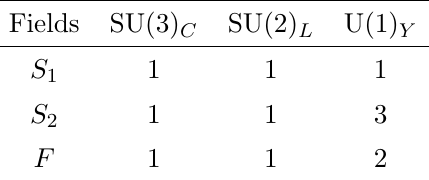
Table 2 . Quantum number assignments for the beyond-the-SM (cid:12)elds of model 1 (compare to (cid:12)gure